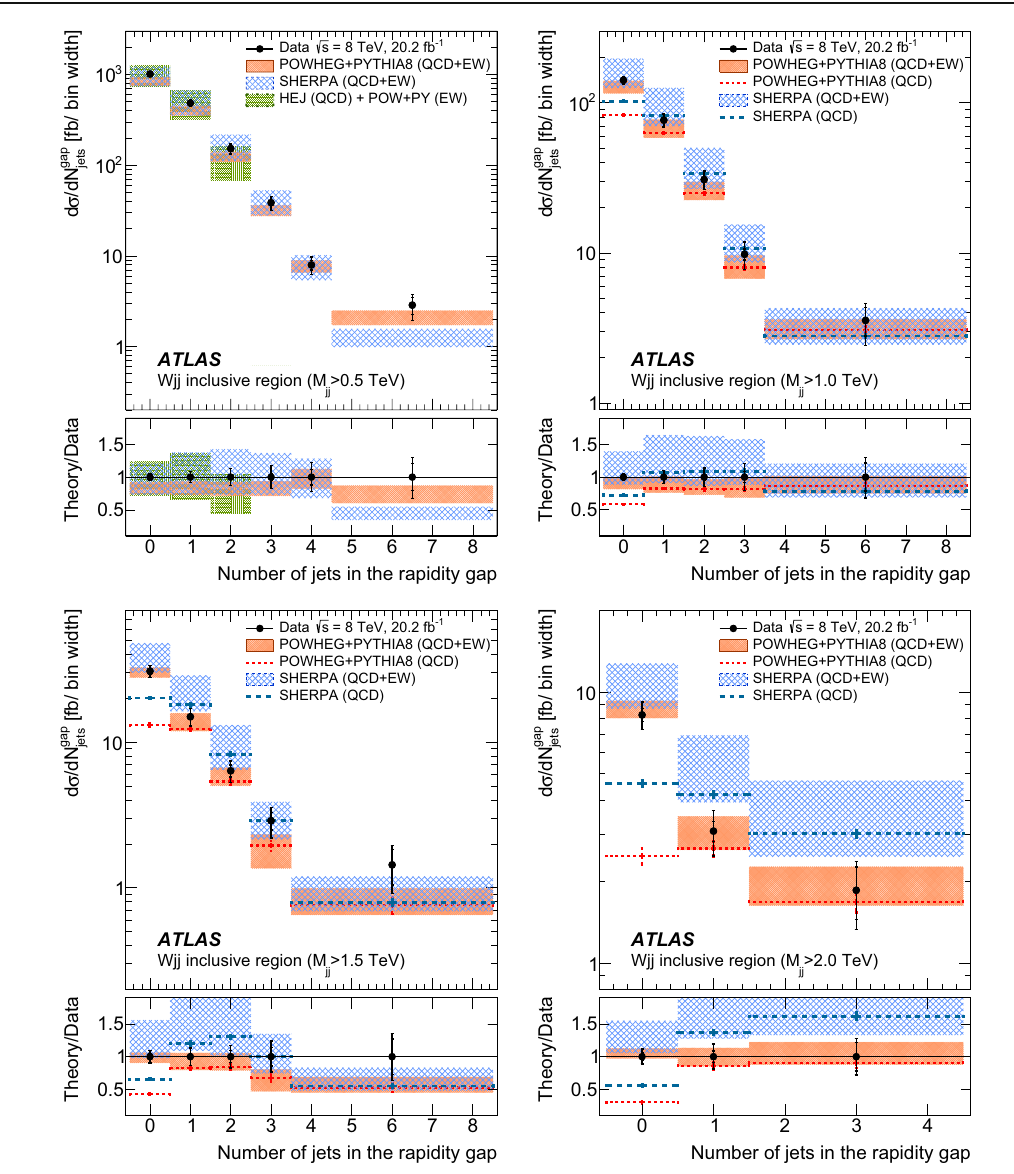
Fig. 35 Differential W jj production cross sections as a function of the number of hard jets in the rapidity interval between the two leading jets in the inclusive fiducial region with four thresholds on the dijet invariant mass (0.5, 1.0, 1.5, and 2.0 TeV). Both statistical ( inner bar )